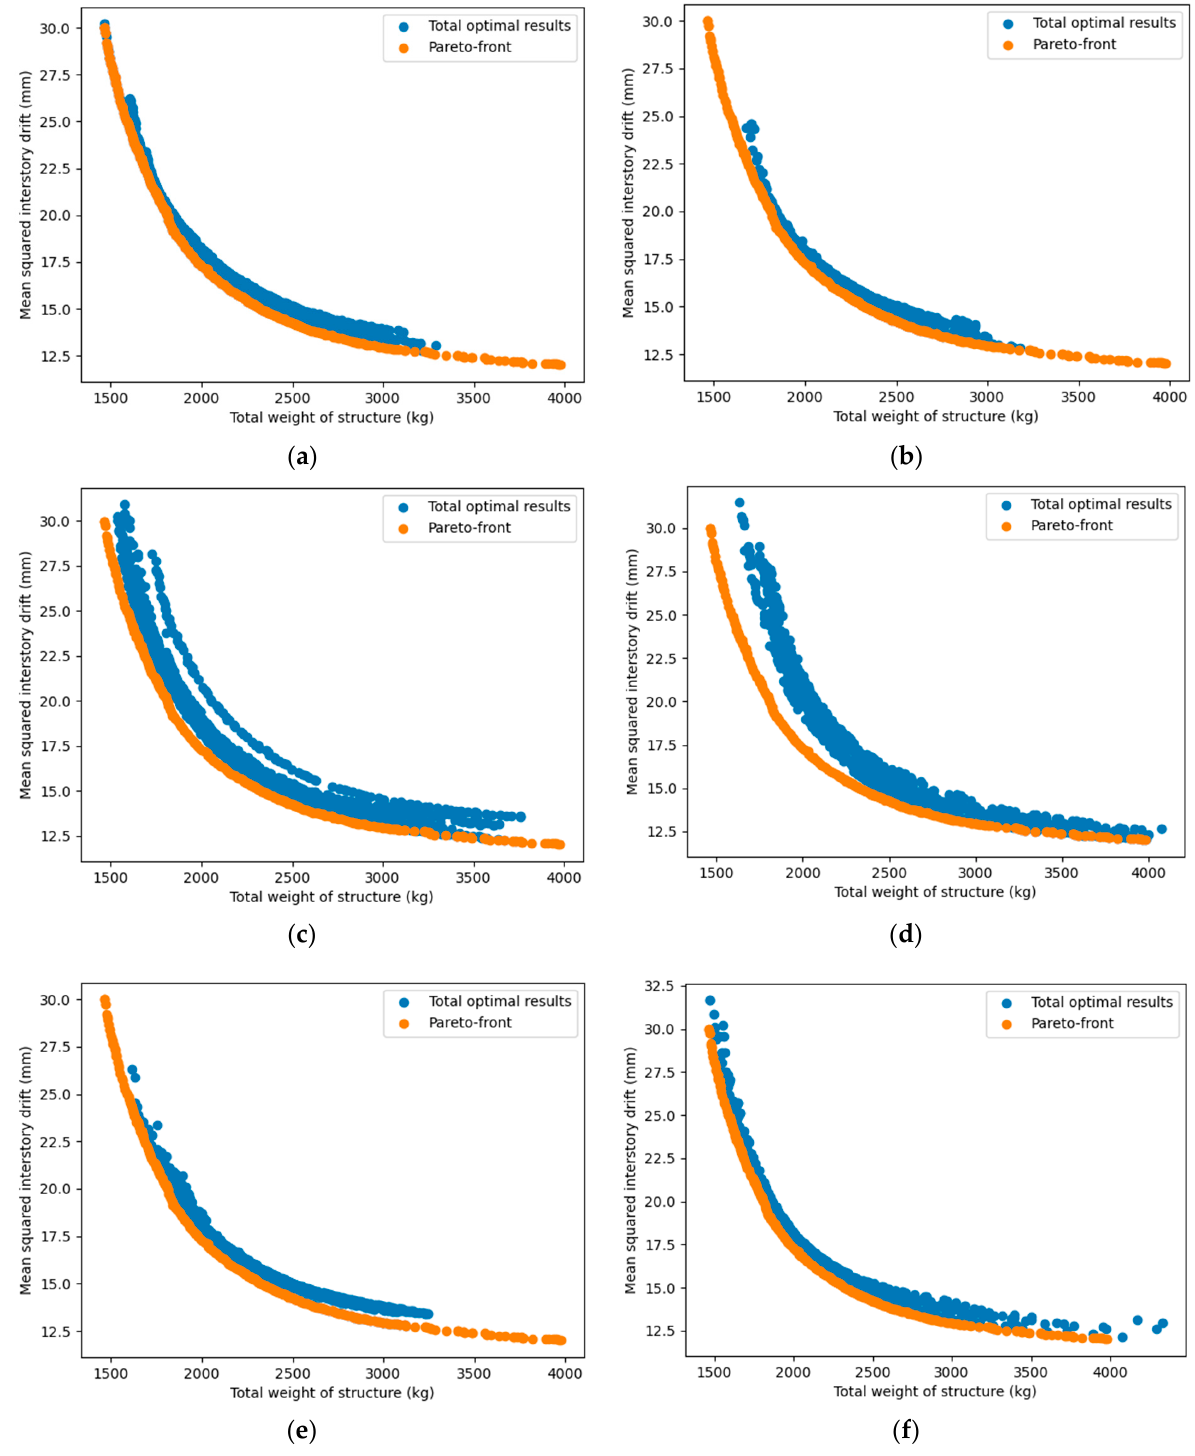
Figure 17. Paretal-front compared to the optimal solutions of the MOO algorithms in the 47-bar